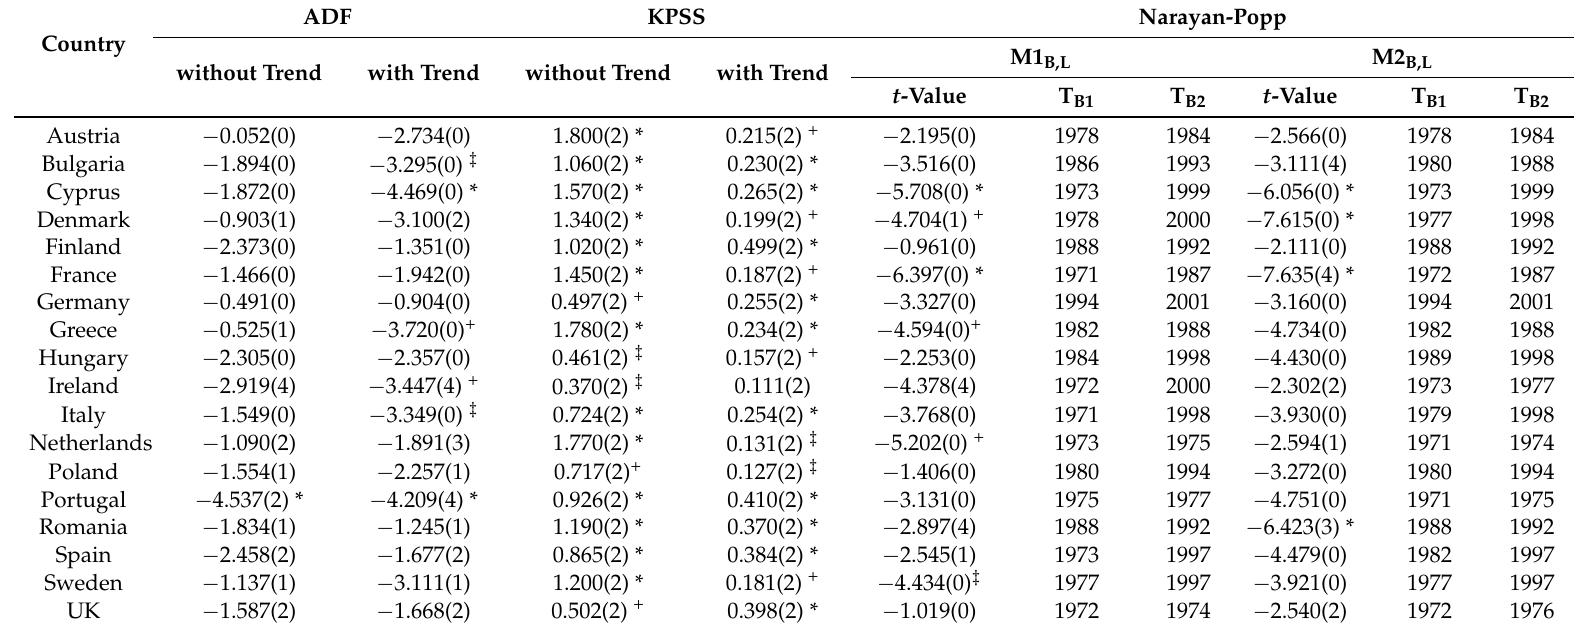
Table 2. Time series unit root test results of wood fuel